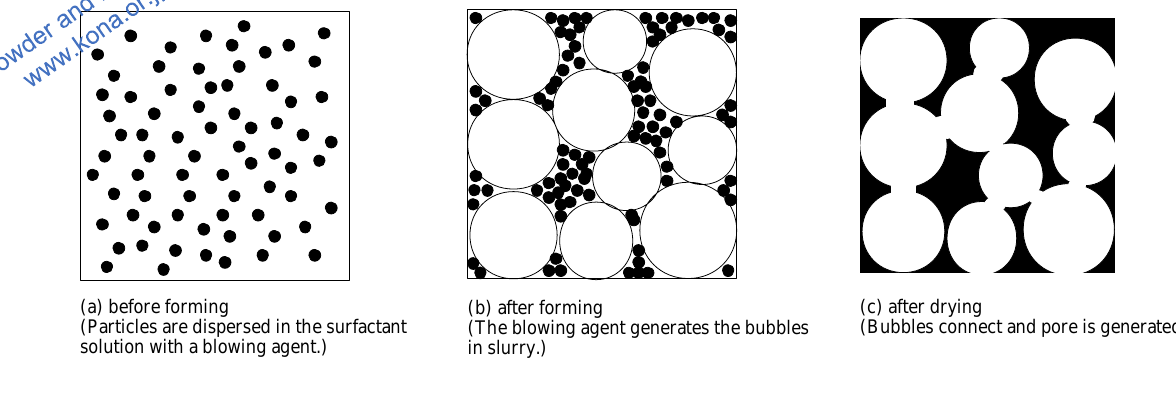
Generation mechanism of pore by using blowing agent (modified from Wada [56]).